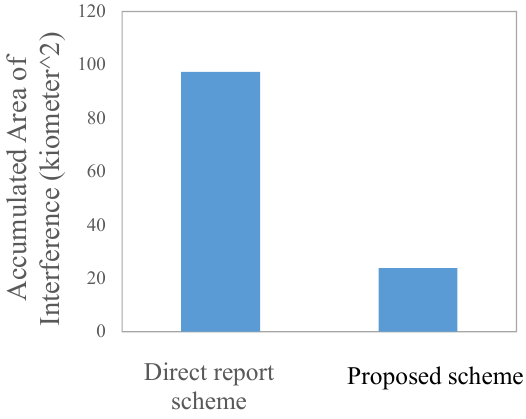
Figure 16. Average resource consumption in Scenario